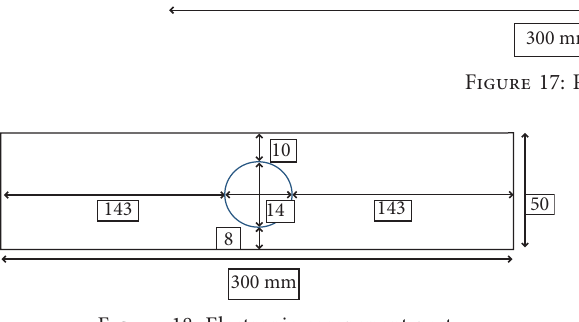
Figure 18: Electronic component part.